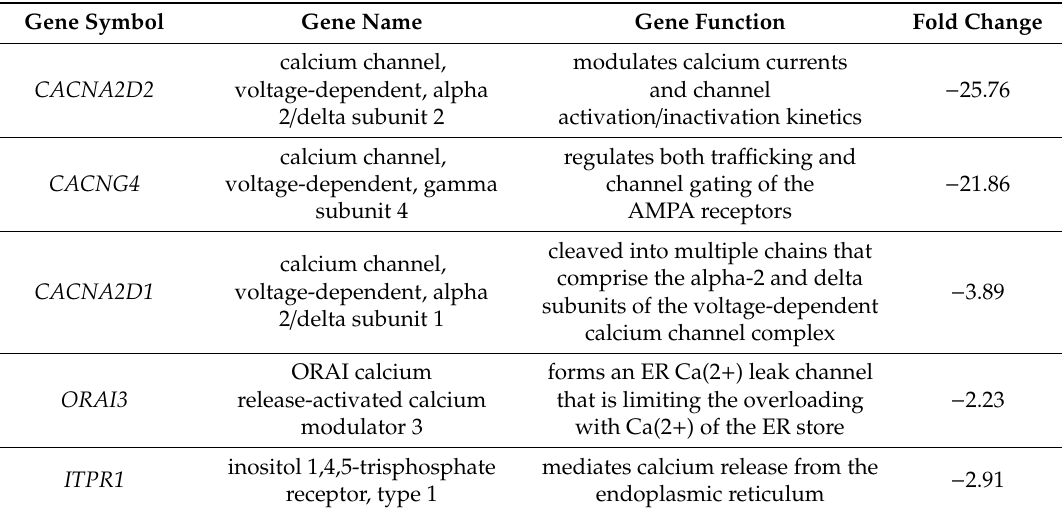
Table 2. The list of most downregulated genes involved in Ca 2 + transport in bortezomib-treated SH-SY5Y cells compared to controls. Gene function according to NCBI Gene database.